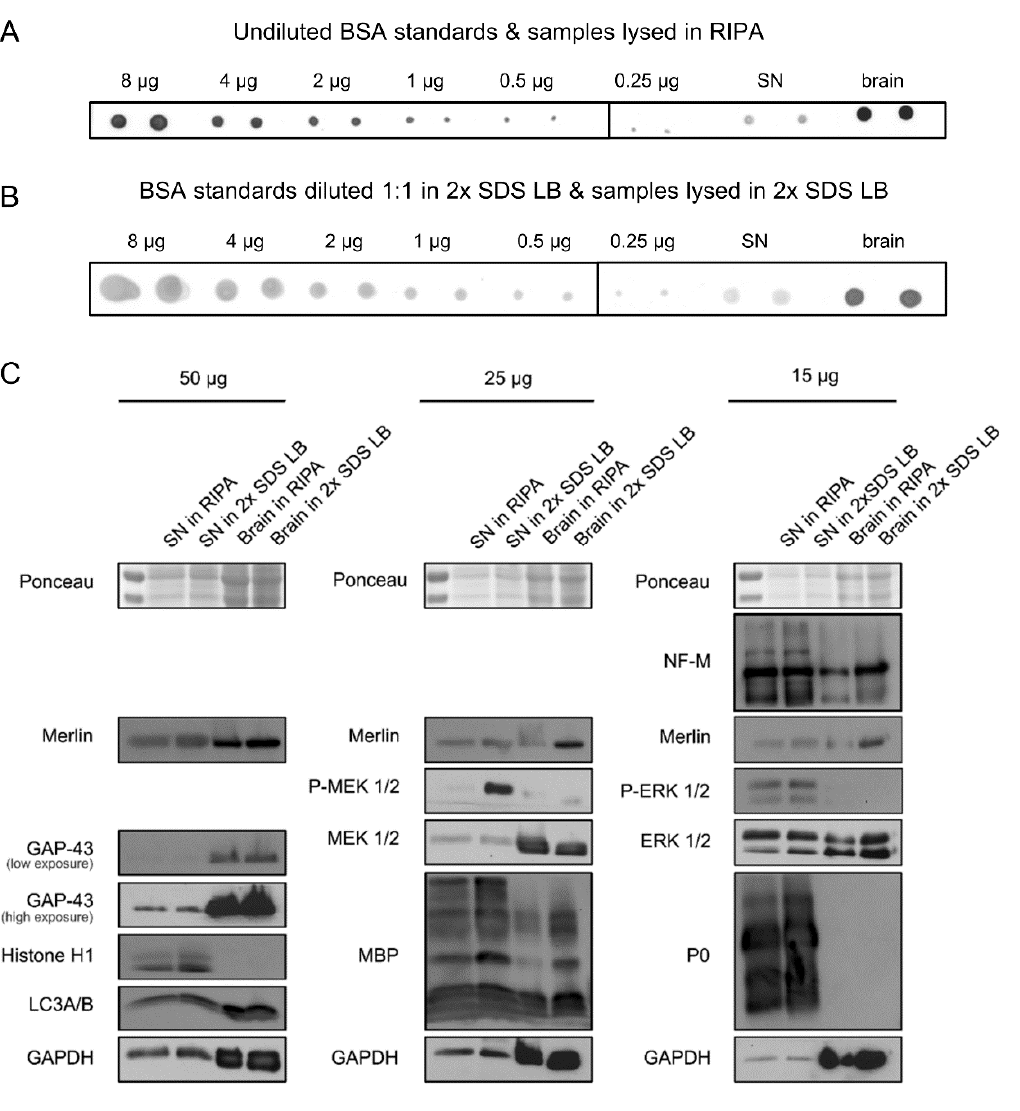
Figure 4. Western blots based on protein quantification with the PDB assay. ( A , B ) Ponceau S-stained dot blot. Undiluted BSA standards and BSA standards diluted 1:1 in 2x SDS lysis buffer were spotted in duplicate onto a membrane (fixed concentration, variable volumes). A quantity of 1 µL of sciatic nerve (SN) and brain samples lysed in 2x SDS LB or RIPA buffer was also applied onto the same membrane for quantification with the PDB assay. ( C ) The nerve and brain lysates containing 50, 25 or 15 µg of total proteins (based on the PDB assay) were loaded for SDS-PAGE and Western blot. After protein transfer to a nitrocellulose membrane, the membrane was also stained with Ponceau S.